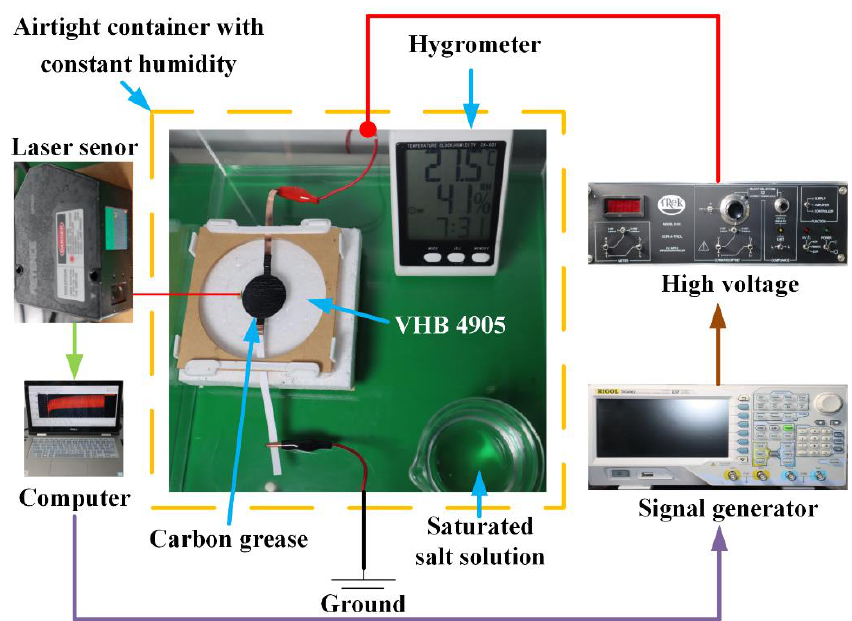
Figure 1. Experimental procedures of VHB 4905 film under different humidity levels.